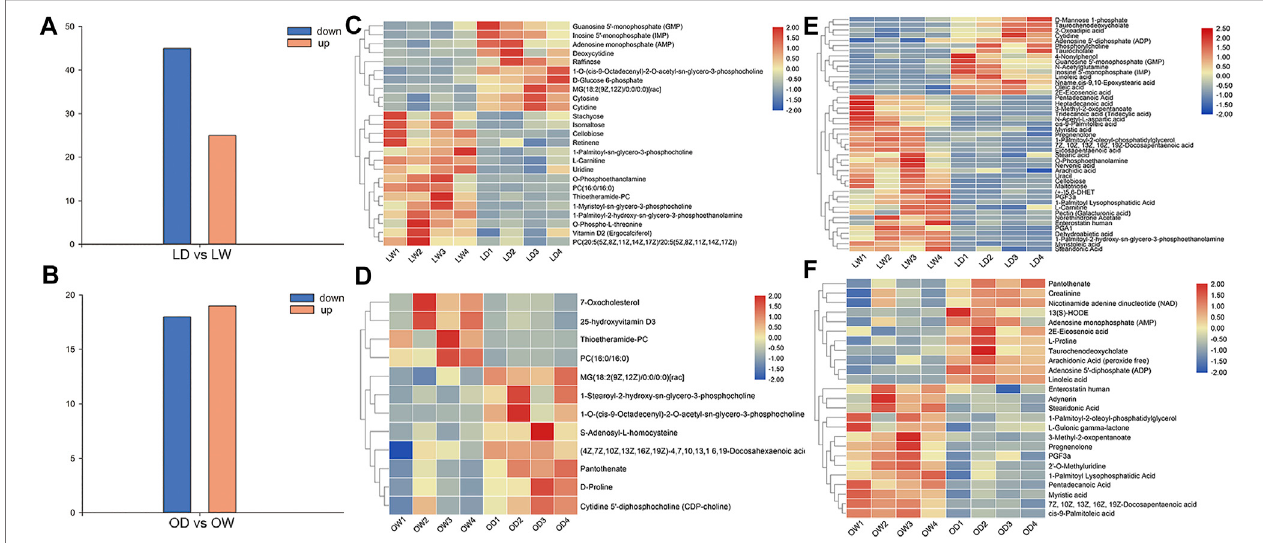
FIGURE 3 | Differentially accumulated metabolites (DAMs) between the wild and captive-reared S. o ’ connori in both liver and oocyte. Number of DAMs in liver (A) andoocyte (B) .HierarchicalclusteringanalysisofDAMsusingbothpositive (C,D) andnegative (E,F) ionizationmodeinliver (C,E) andoocyte (D,F) .LW,liverfromwild S. o ’ connori ; LD, liver from domestic S. o ’ connori ; OW, oocyte from wild S. o ’ connori ; OD, oocyte from domestic S. o ’ connori .